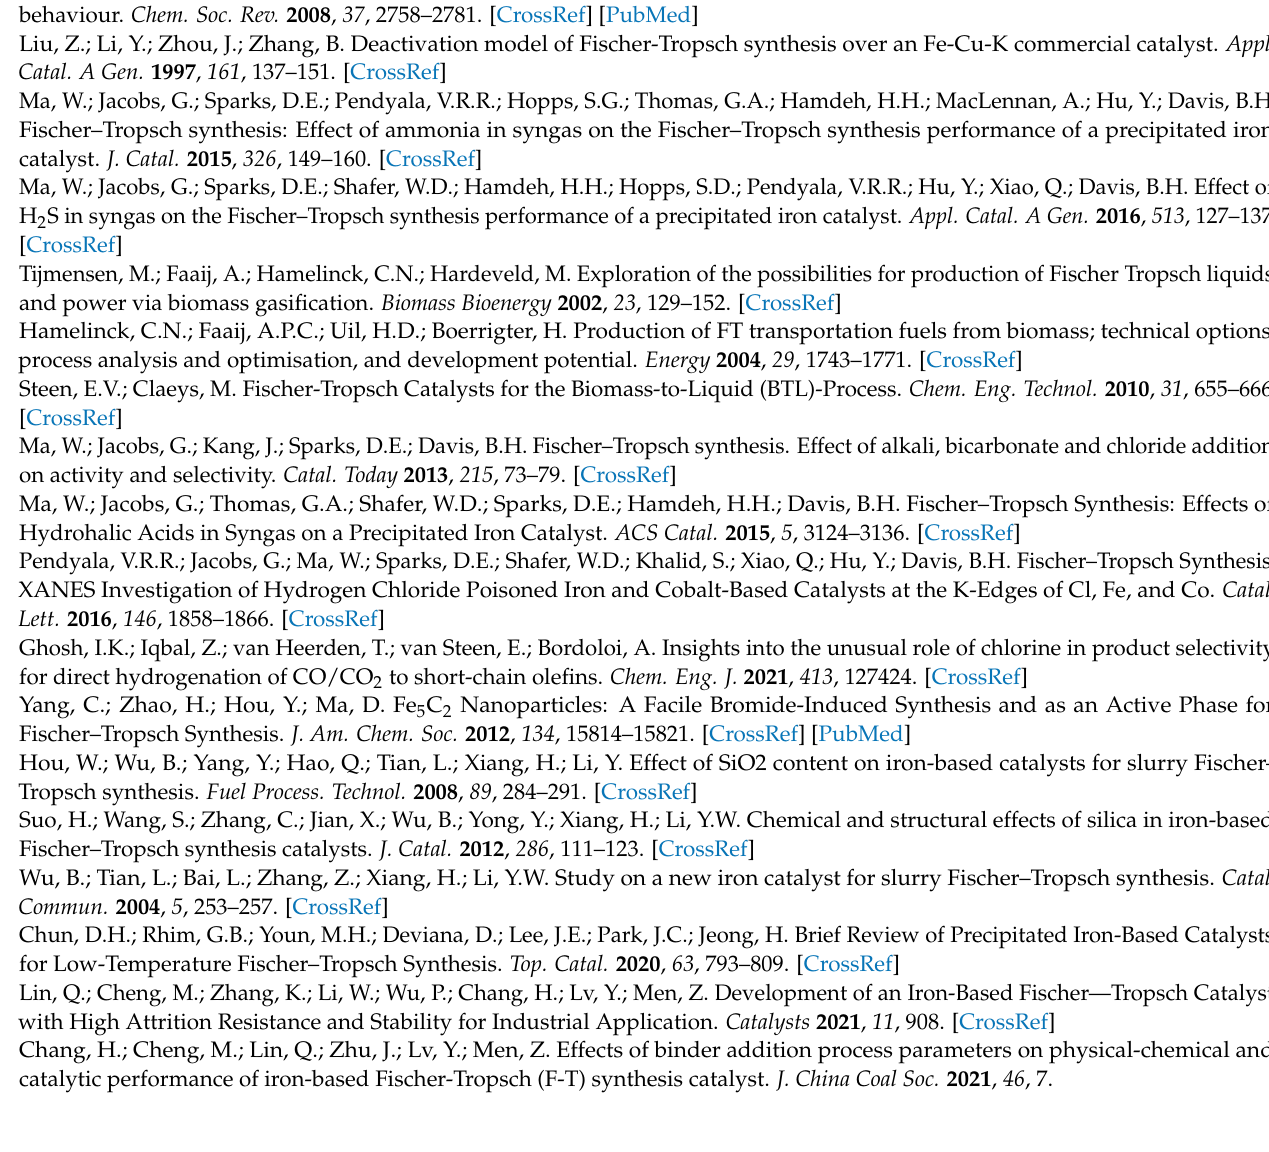
Table S2: Binding energy of Cl0 and Cl1 before and after Fischer-Tropsch synthesis. Figure S1: Flow diagram of the 1 L stirred tank reactor; Figure S2: Picture of the 1 L stirred tank